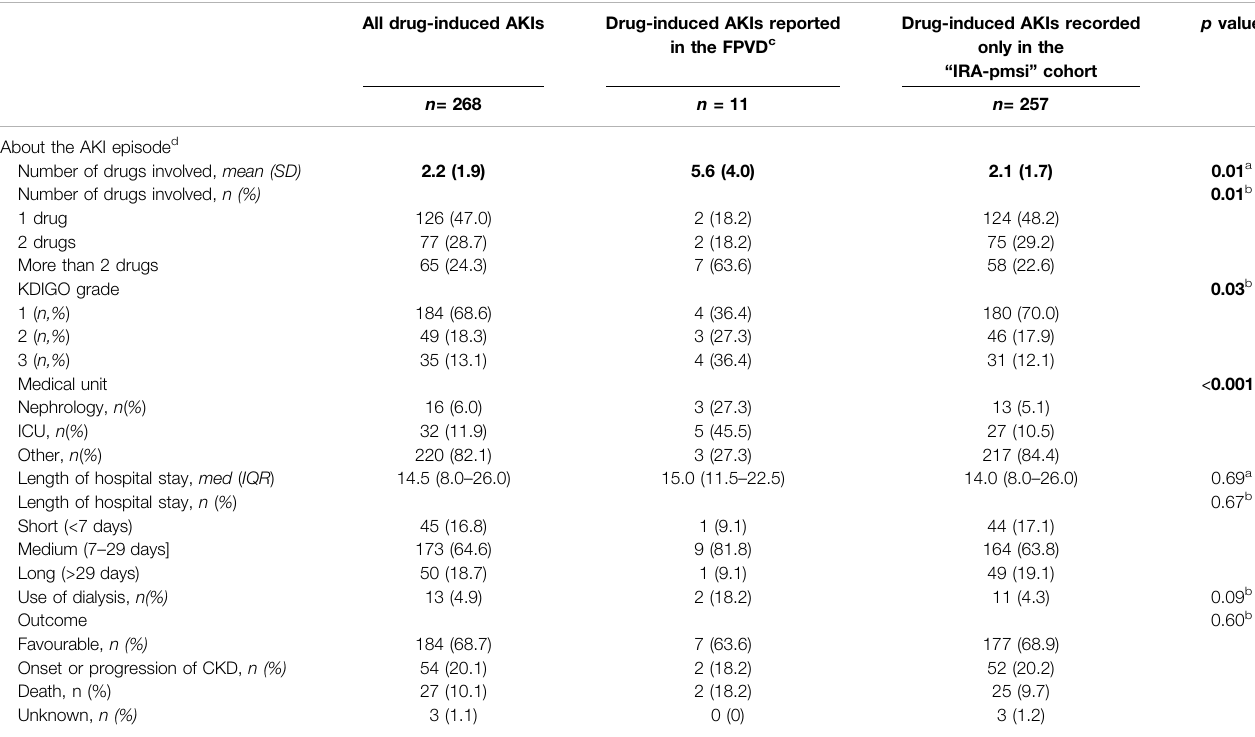
p value Drug-induced AKIs recorded All drug-induced AKIs Drug-induced AKIs reported only in the in the FPVD c “ IRA-pmsi ” cohort n = 268 n = 11 n = 257